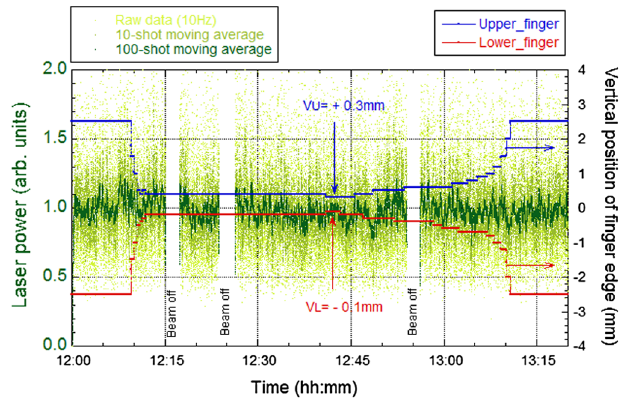
FIG. 18. Behavior of laser power (left axis) and vertical posi- tion of edges of rf fingers (right axis) over time. The minimum gap is 0.4 mm at approximately 12:42 .